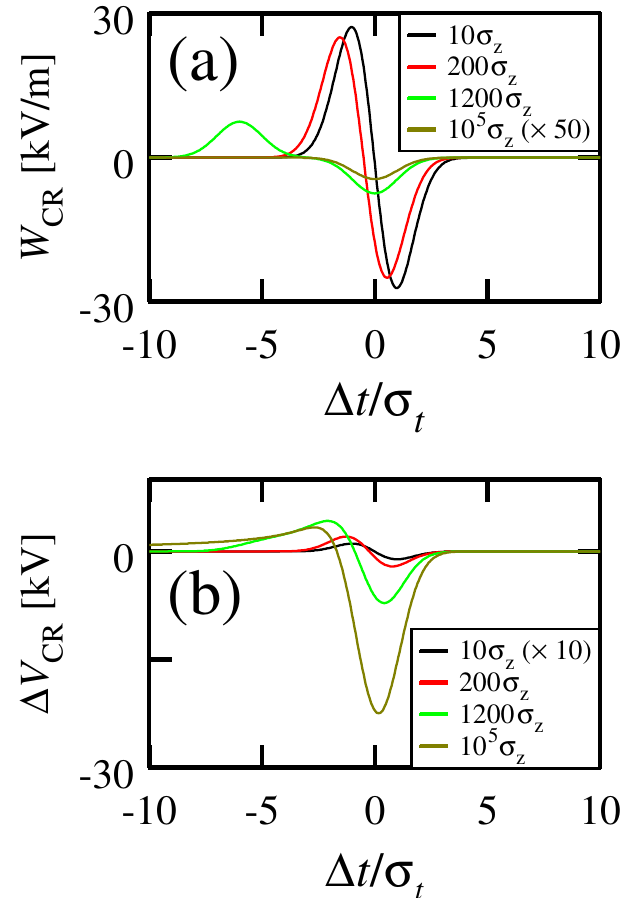
FIG. 2. (Color) Coherent-radiation wakes for a strong magnet that deflects a bunch through the angle (cid:1) ¼ 100 =(cid:2) . The 511- MeV 200-pC Gaussian bunch has (cid:3) z ¼ 400 (cid:9) m and r b ¼ 0 : 1 (cid:3) z . (a) Coherent-radiation wake at four distances downstream of the magnet. (b) Integrated coherent-radiation wake at the same four